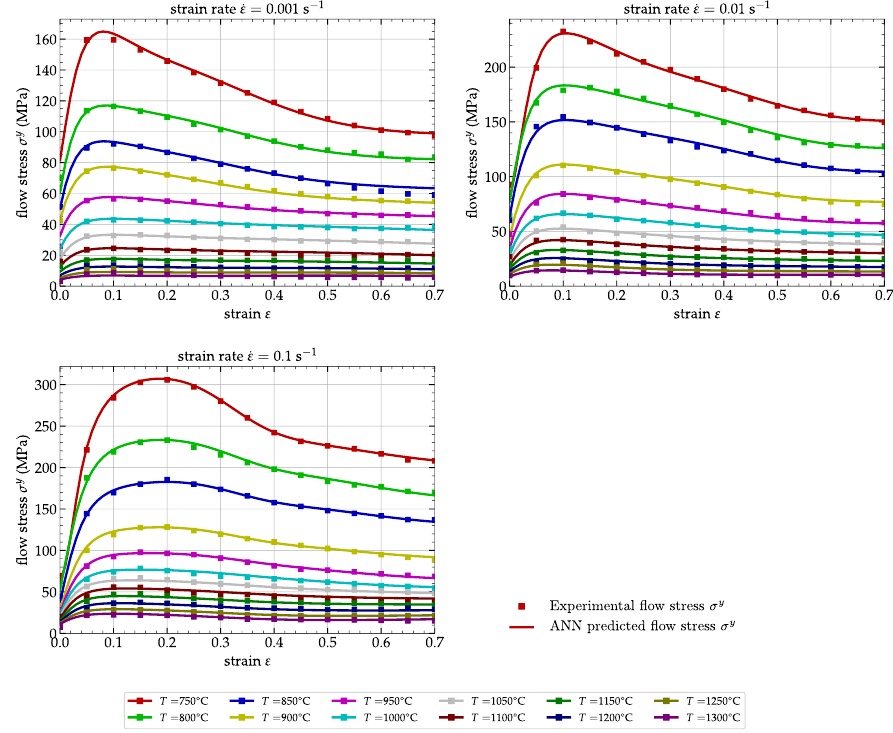
Figure 4. Comparison of the flow stress σ y predicted by the 3-7-4-1 ANN (continuous line) and the experimental data for the GCr15 (square markers).